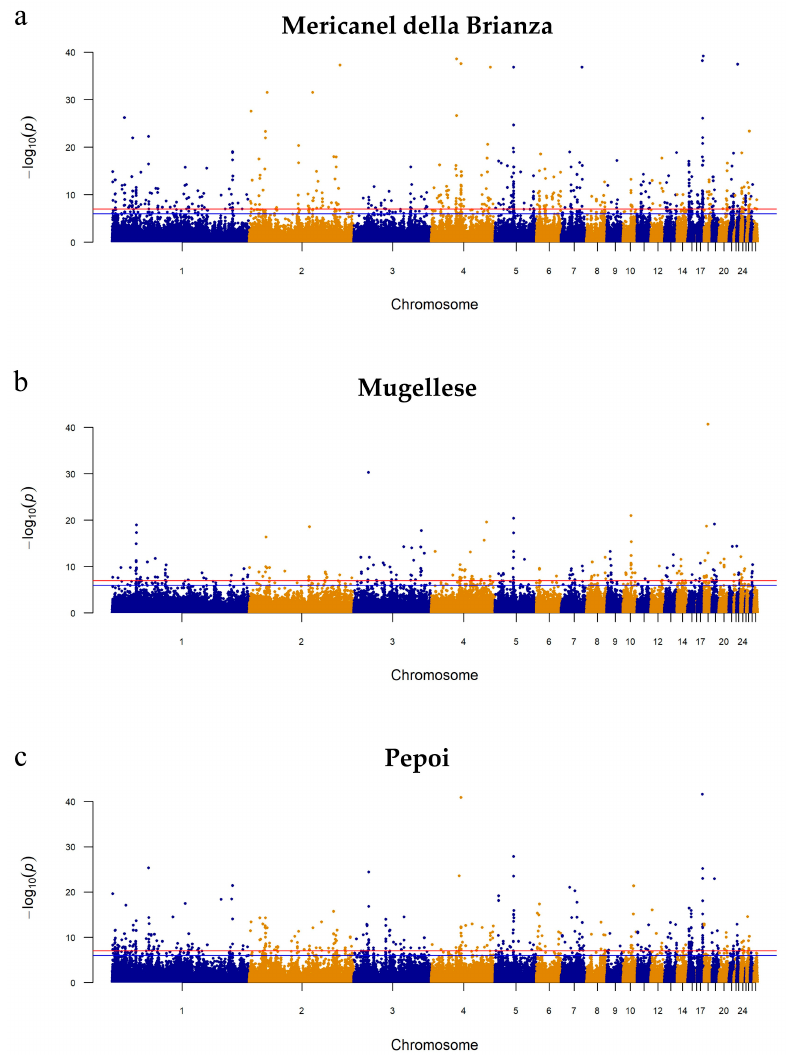
Figure 2. Manhattan plot of ( a ) Mericanel della Brianza, ( b ) Mugellese, and ( c ) Pepoi against the control population. The red line represents the p -value < − log10(1 × 10 − 7 ). The blue line represents suggestive significance, with a value of − log10(1 × 10 − 6 ).